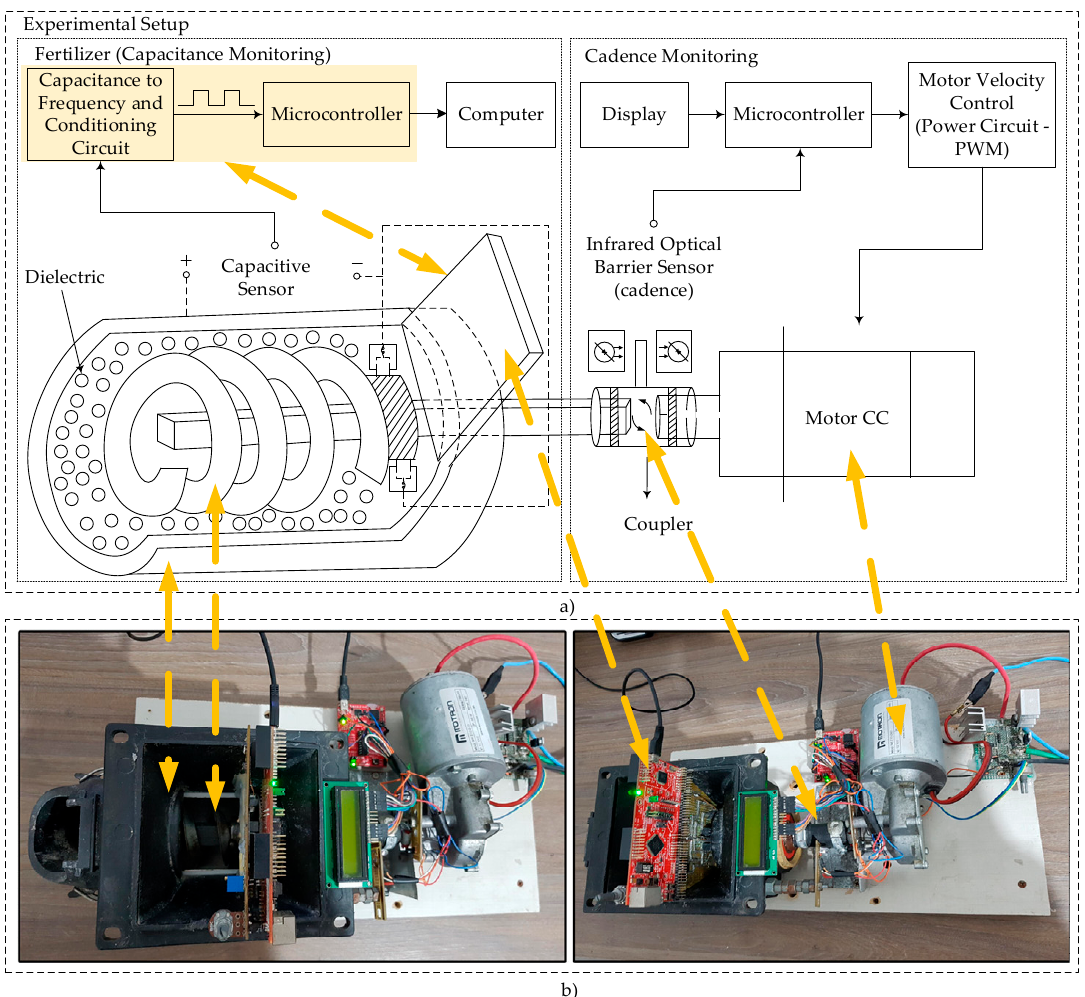
Figure 4. ( a ) Diagram of the developed prototype scheme. ( b ) Photos in two different profiles for better visualization of the parts of the prototype used in bench tests.